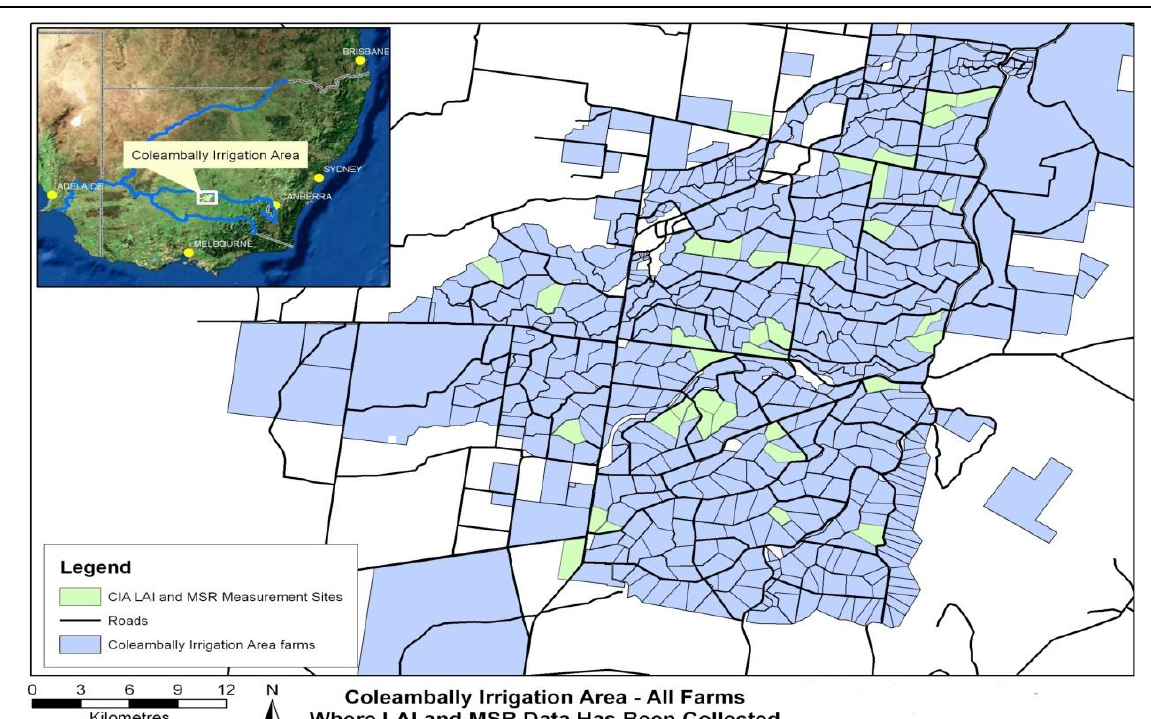
Figure 1: Locations of LAI and MSR data collection in the